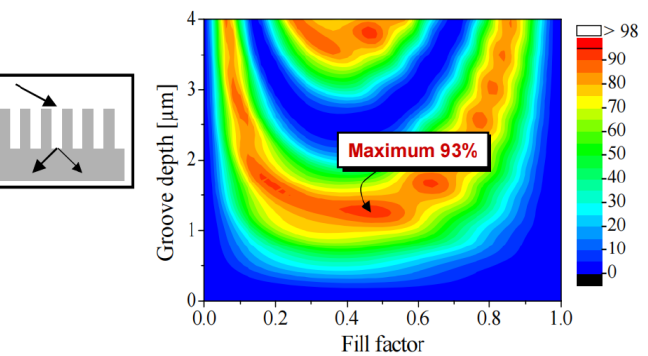
Figure 26. Numerical simulation of the diffraction efficiency of the corresponding surface ‐ relief grating. The maximum diffraction efficiency was 93%.